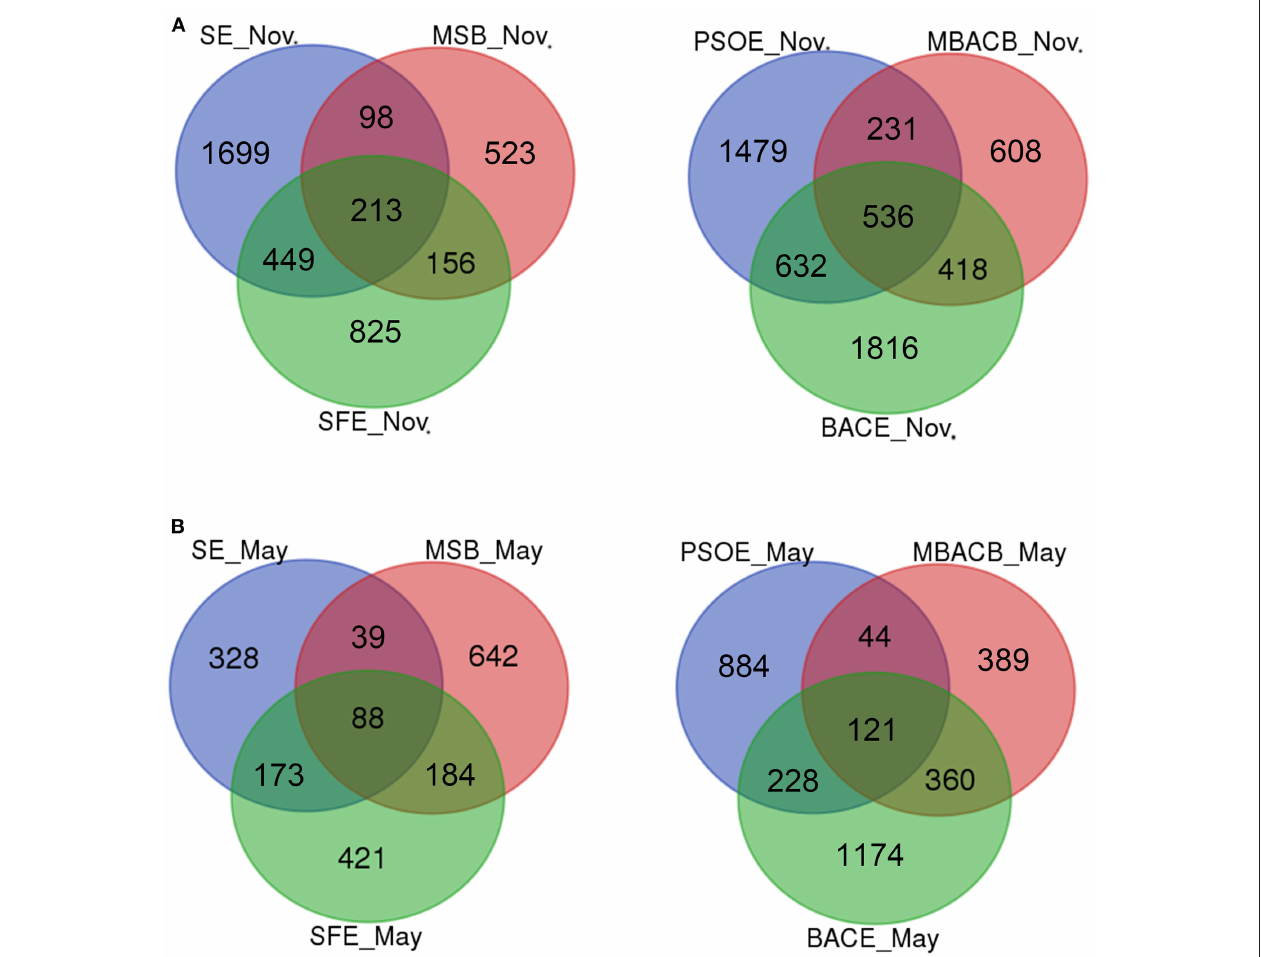
FIGURE 4 | Venn diagrams showing the number of shared OTUs between filter biofilms and their corresponding influents and effluents in November (A) and May (B) . The abbreviations are the same as used in Table 2